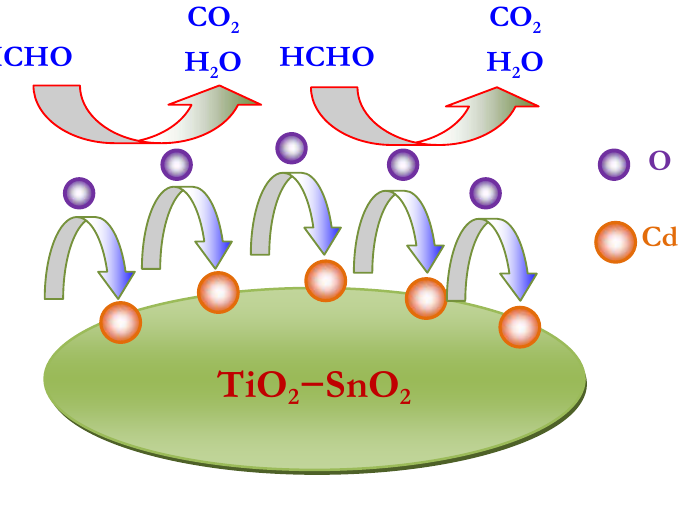
Figure 8. Schematic plot illustrating the sensing mechanism of the Cd-doped sensor. Note that the Cd and O represent the interaction between Cd additives and pre-absorbed oxygen